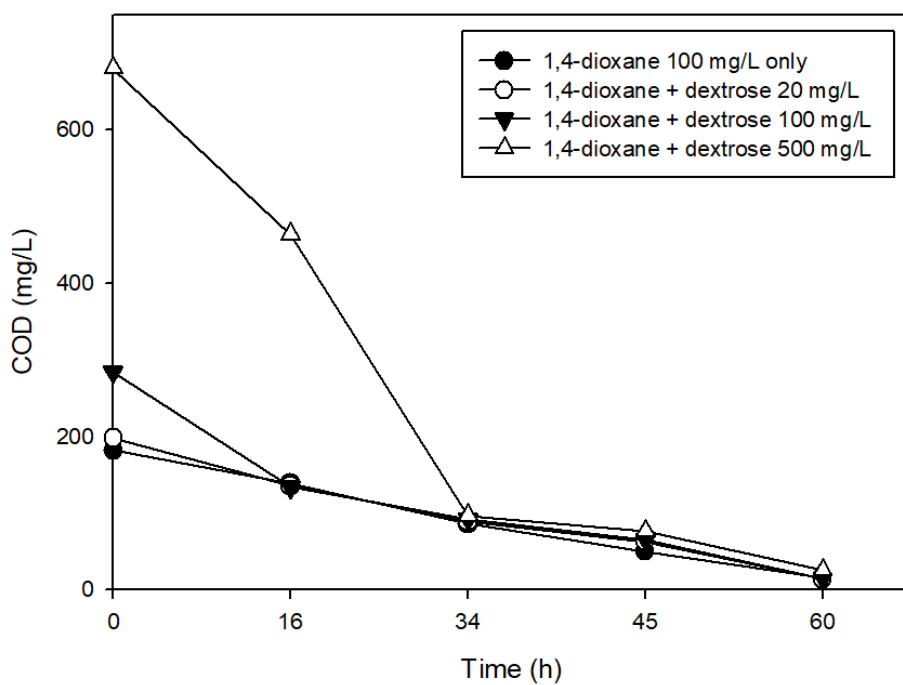
Figure 3. The change of soluble COD during the biodegradation of 1,4-dioxane and dextrose.